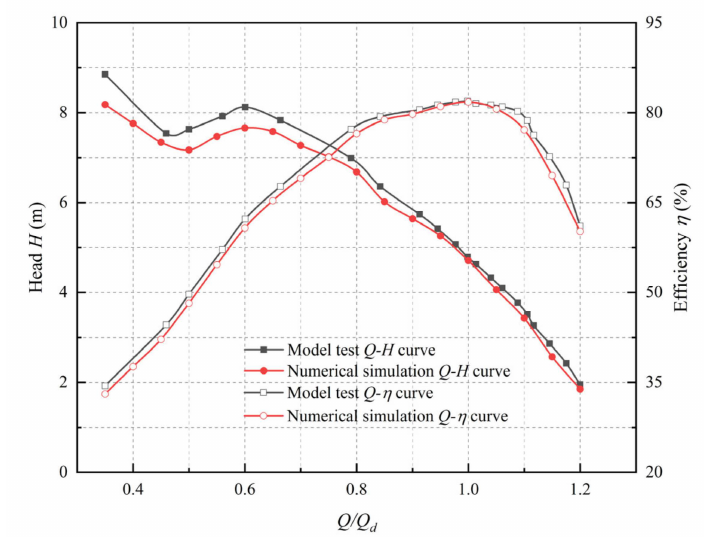
Figure 6. Comparison of the experimental and numerical simulation